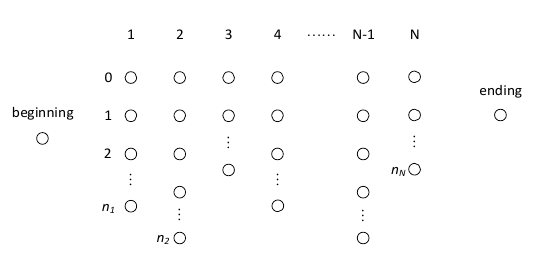
Figure 7. Ant colony algorithm search path diagram.